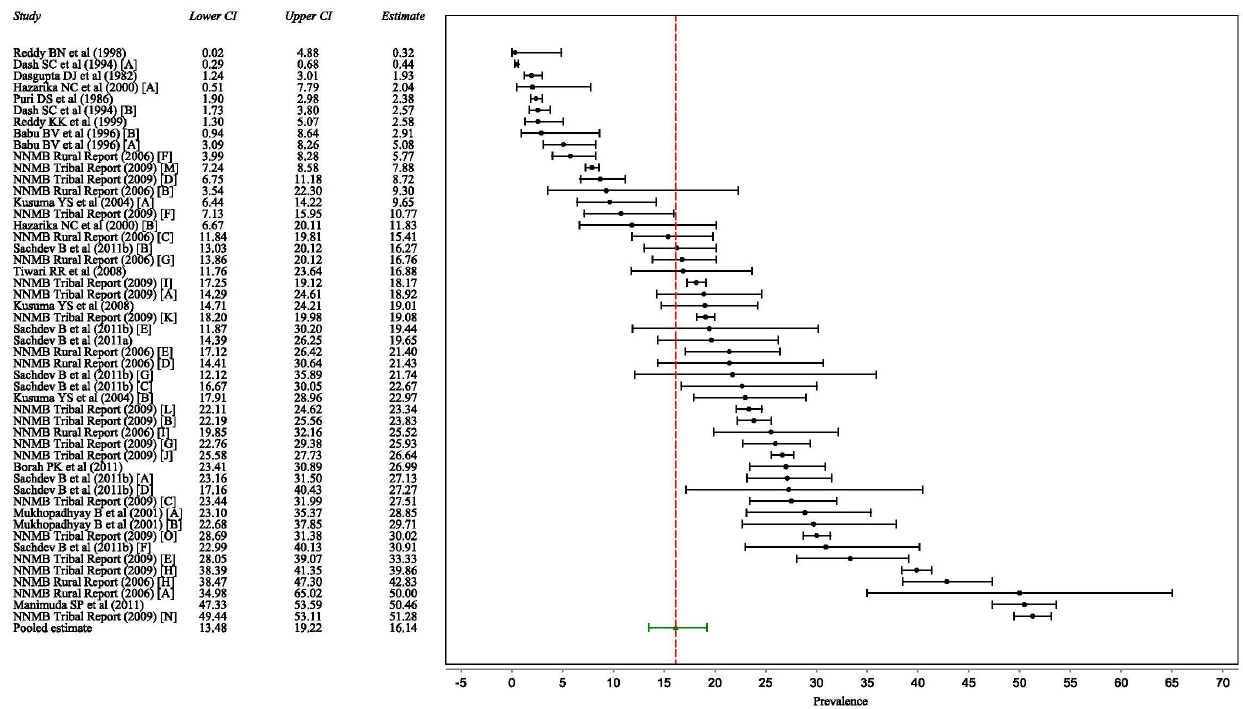
Figure 2. Forest plot of studies on hypertension prevalence.